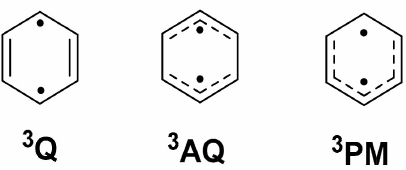
Figure 5. The quinoid ( Q ), anti-quinoid ( AQ ), and pentadienyl-methyl ( PM ) conformers of T 1 -state